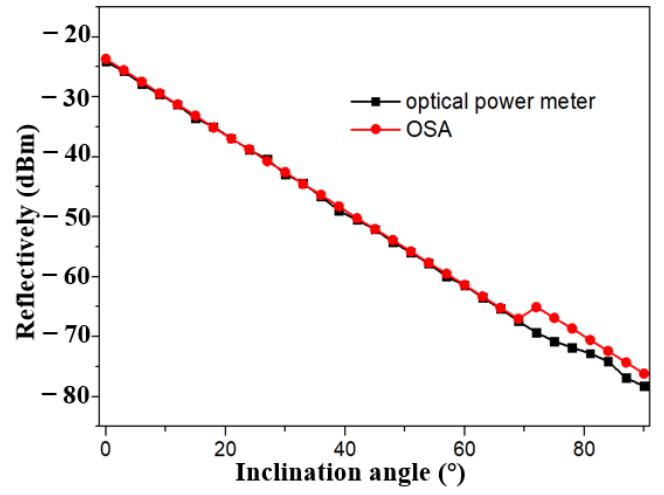
Figure 6. Optical power at peak reflection wavelength for various inclination angle (red line: optical power meter; black line: OSA).